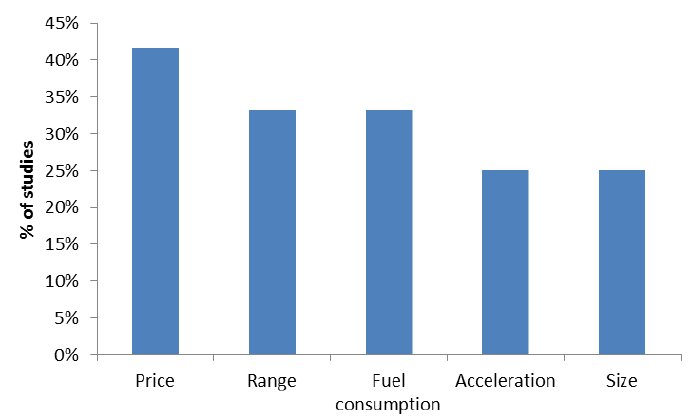
Figure 7. Frequency of vehicle attributes analyzed more often.